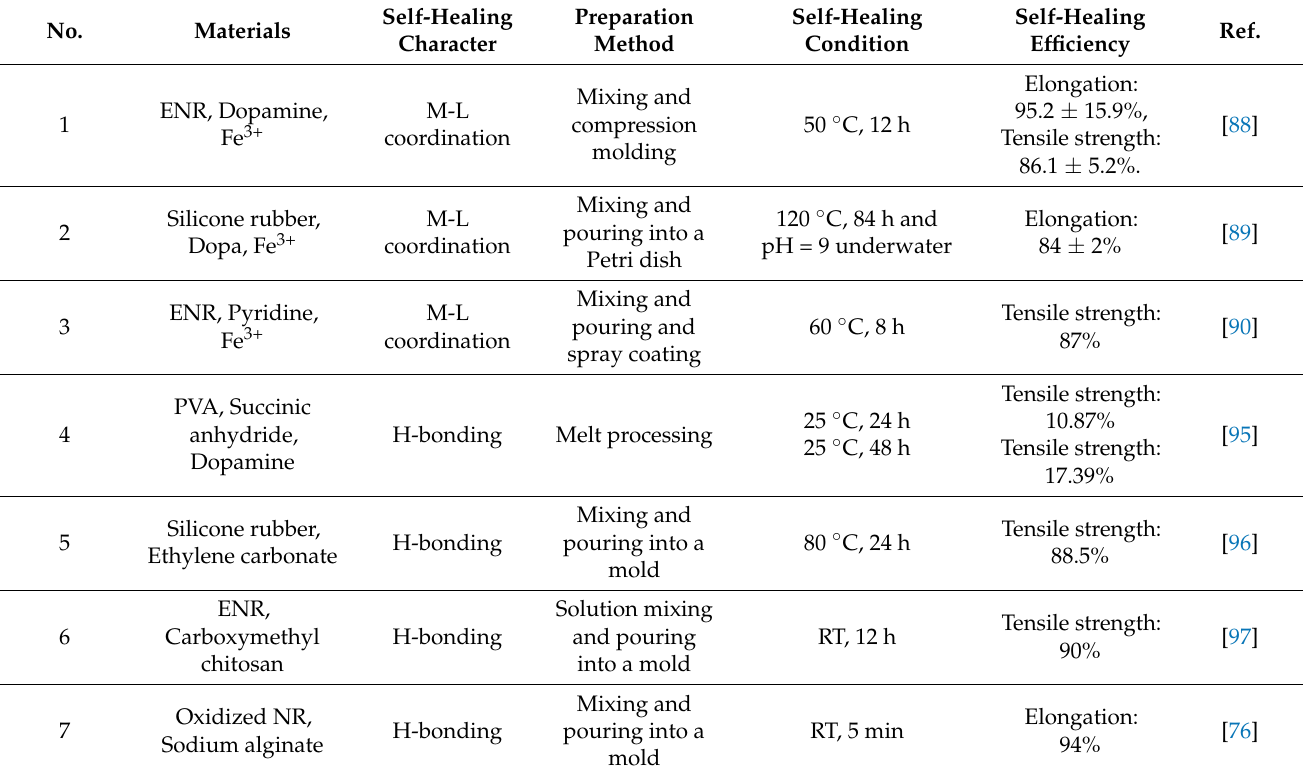
Table 8. Summary of self-healing